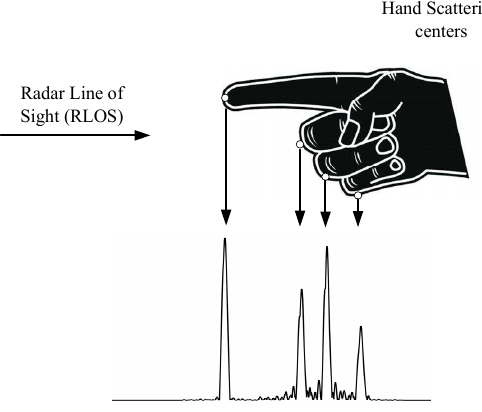
Figure 3. The high-resolution range profile (HRRP) from a hand in the radar line of sight (LOS), in which the circles represent sources of scattering points.